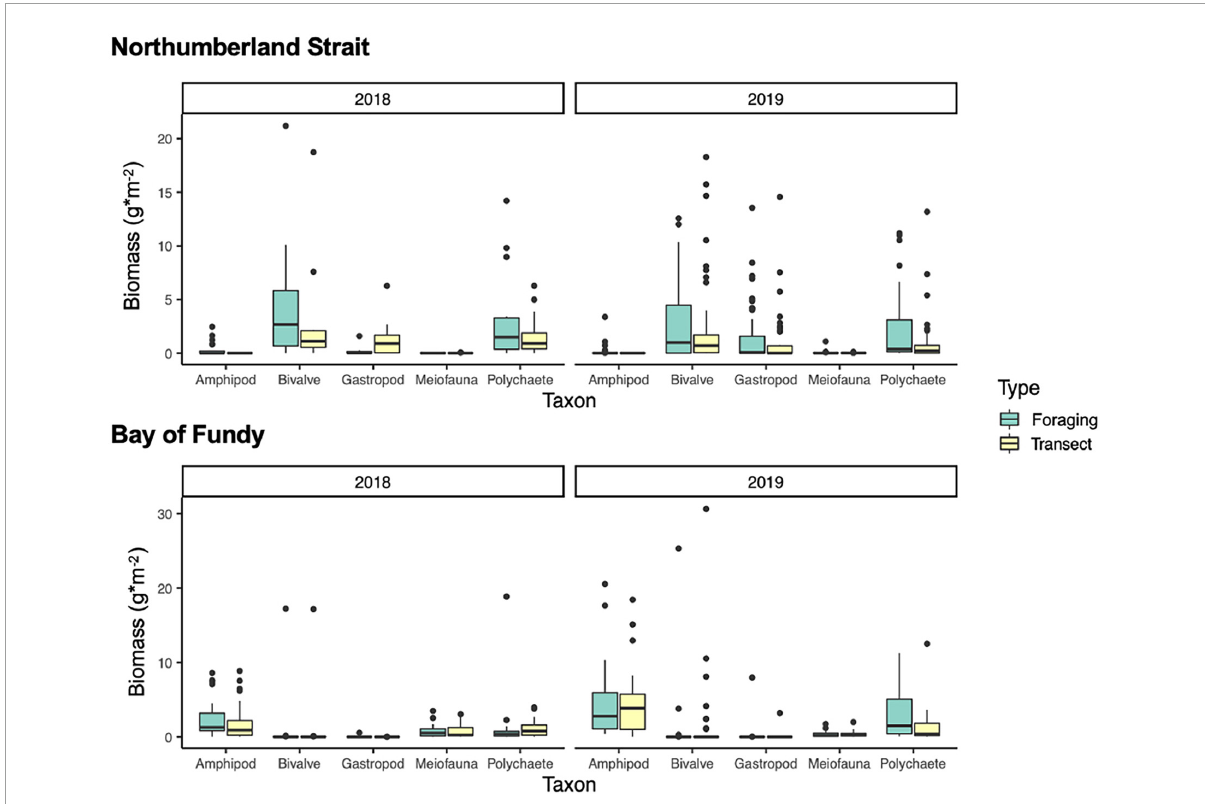
FIGURE2 Dry biomass (g · m − 2 ) of invertebrates in 2018 (left) and 2019 (right) in the Northumberland Strait (top) and Bay of Fundy (bottom) in locations where birds were foraging (represented selected habitat) and on transects (representing available habitat). Center line represents the median, with first and third quartiles shown in boxes. Whiskers show interquartile range. Points show data beyond the 5th and 95th percentile. Note that the y -axis scale differs between